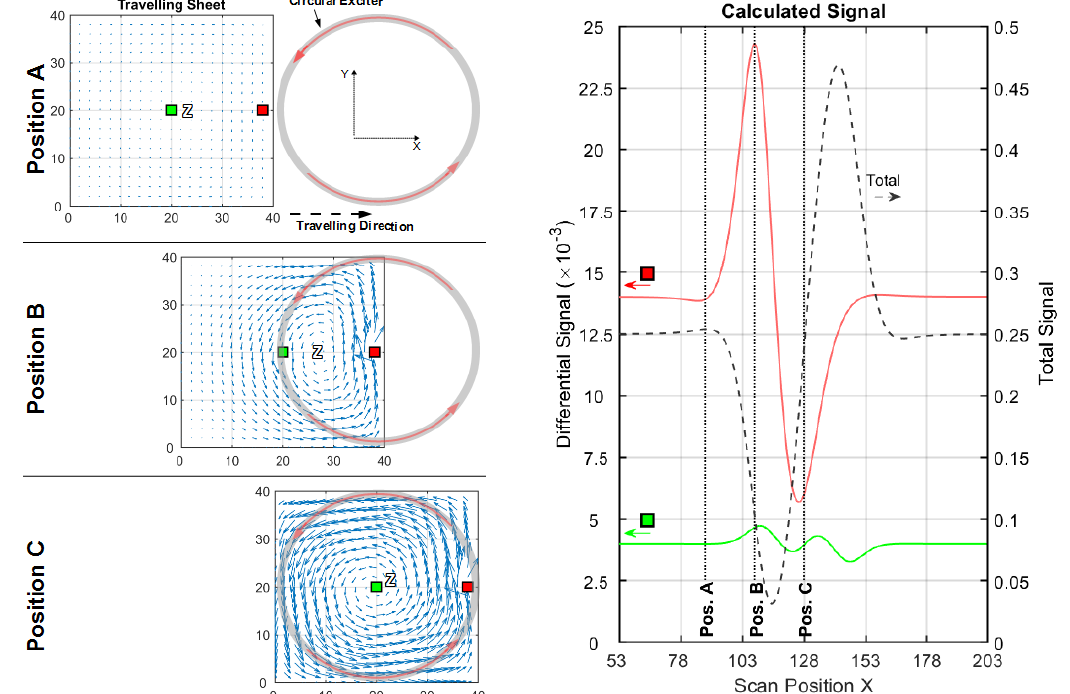
Figure 5. Current and signal calculations with a circular setup (cf. Figure 3a); ( left ) Travelling 2D sheet with local voids (green and red squares) in front of a circular exciter. Blue arrows depict the current direction and intensity. Only three significant x-positions (A, B and C) are shown; ( right ) Total (dotted black line) and differential signals for a void in the center (green line) and for a void at the edge (red line). Table 1. Main results from the calculated signals, shown in Figure 5.